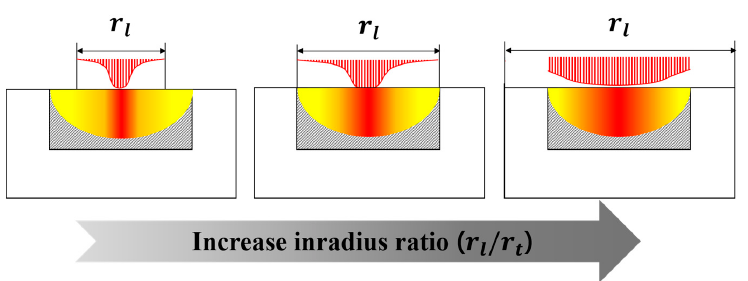
Figure 9. Laser profile changes with increasing radius ratio ( r l / r t ).